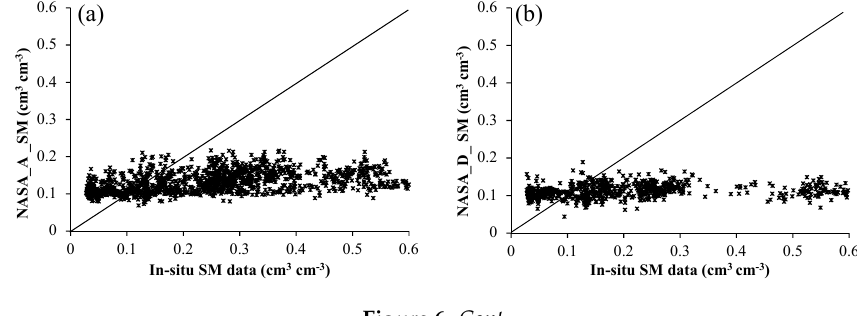
0.6 cm 3 cm − 3 (Figure